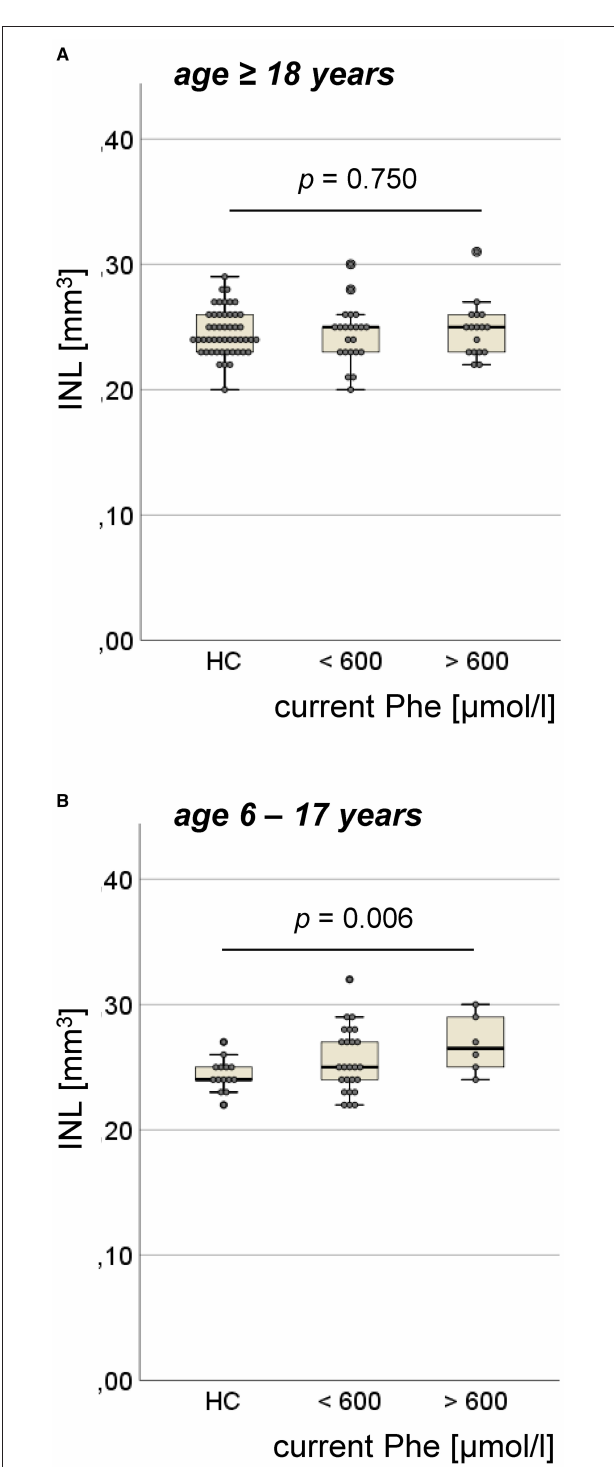
FIGURE 3 | Volume of inner nuclear layer (INL) in the ETPKU patients. (A) ETPKU ≥ 18 years of age with current Phe level < 600 µ mol/L ( N = 22) or > 600 µ mol/L ( N = 17), and HCs ( N = 49). (B) ETPKU 6–17 years of age with current Phe level < 600 µ mol/L ( N = 25) or > 600 µ mol/L ( N = 6), and HCs ( N = 14). The p -values are given for comparison between ETPKU with current Phe level > 600 µ mol/L and HCs.